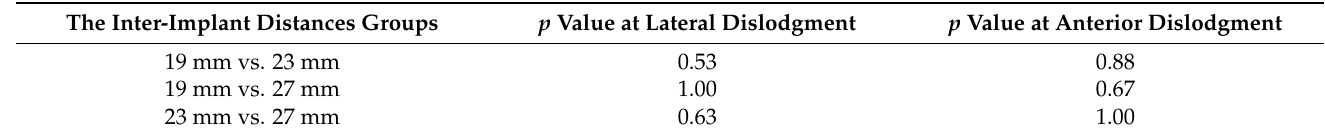
Table 4. The significance level of Tukey post hoc test for post-placement/removal lateral and anterior dislodgments within two MDIs groups; the mean difference is significant at the 0.05